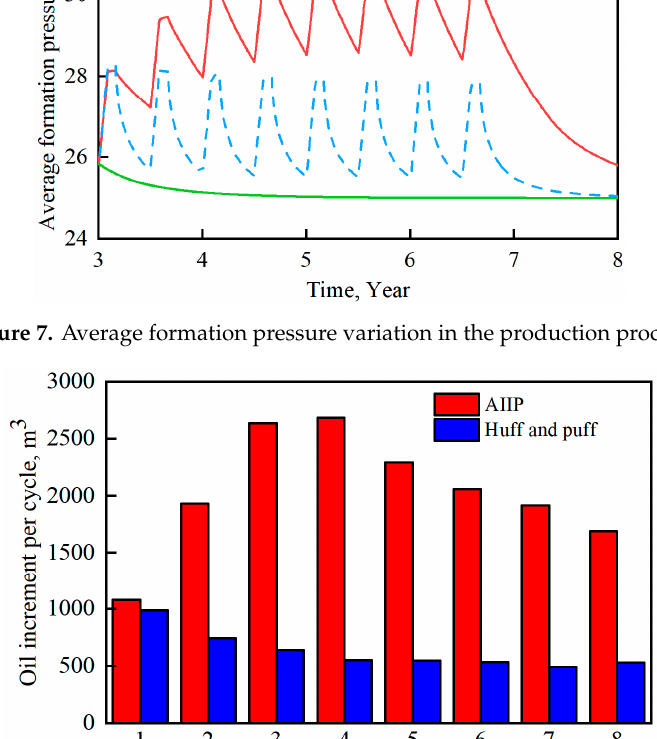
ff erent hu ff -n-pu ff Figure 8. Comparisons of oil increment in different huff-n-puff cycles. Figure 8. Comparisons of oil increment in di Figure 8. Comparisons of oil increment in different huff-n-puff cycles.